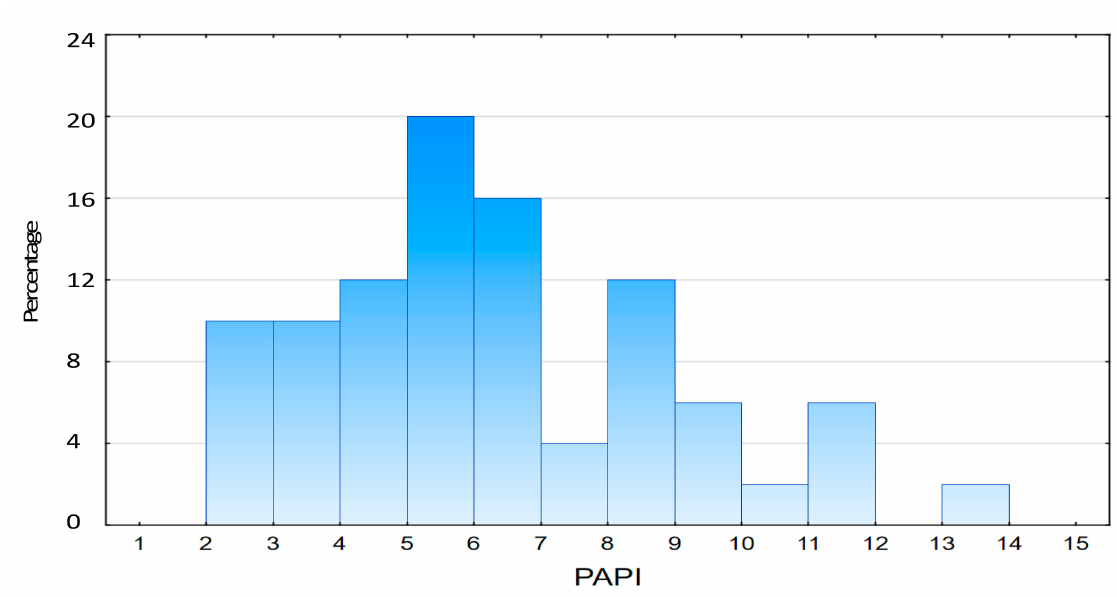
Figure 1. Distribution of PAPI among study population. Abbreviations: PAPI, pulmonary artery pulsatility index.